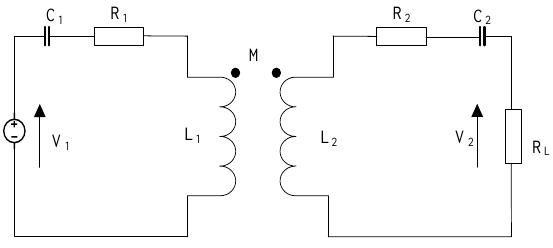
Figure 2. Equivalent circuit model for a Series-Series (SS) topology.